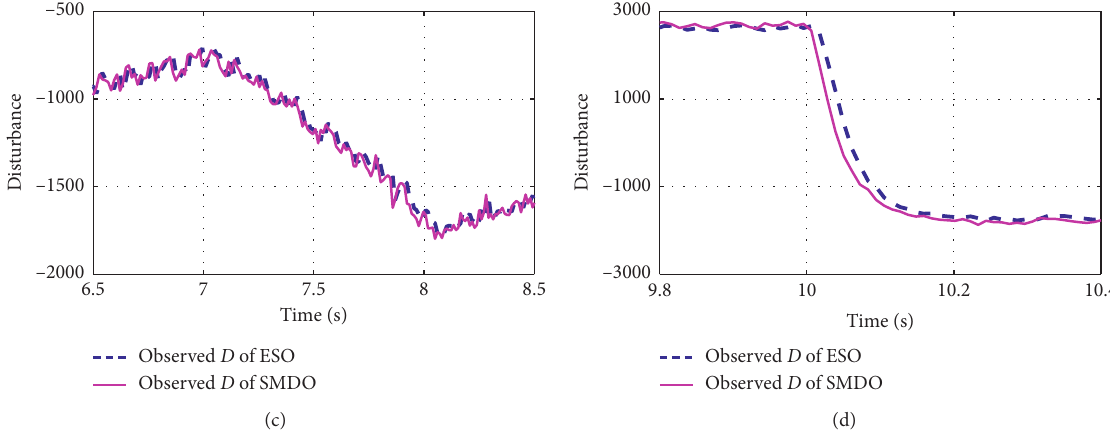
Figure 7: The detailed disturbance observation comparison of the ESO and SMDO. (a) The convergence process. (b) Unloading process. (c) Acceleration process. (d) Loading process.